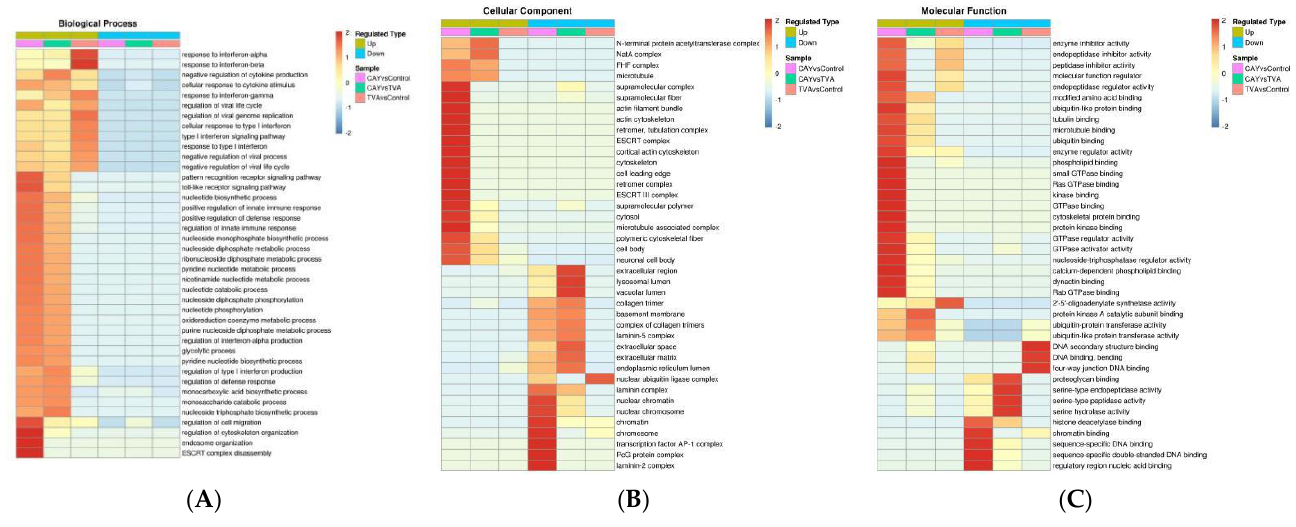
Figure 5. Cluster analysis heat map based on GO enrichment classifications: biological process ( A ); cellular component ( B ); molecular function ( C ). GO enrichment was performed for differential proteins in MAC-T cells under different incubation conditions, and cluster analysis was performed to determine the correlation between the functions of differential proteins. The horizontal direction indicates the enrichment test results of different groups, and the vertical direction shows a description of differential proteins’ enrichment-related functions. Different sets of differential proteins and color blocks correspond with the functional descriptions and indicate the degree of enrichment, where red indicates stronger enrichment (the deeper the red, the stronger the enrichment) and blue indicates weaker enrichment (the lighter the blue, the weaker the